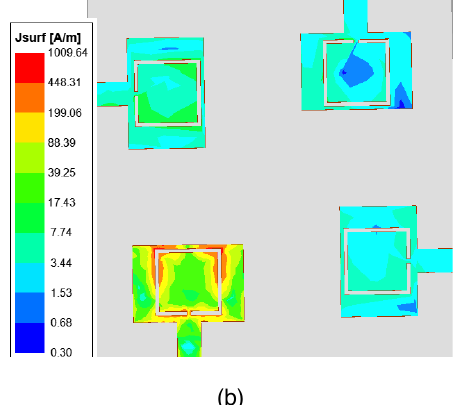
FIGURE 8. The proposed MIMO antenna current distribution at (a) 28 GHz and (b) 38 GHz.